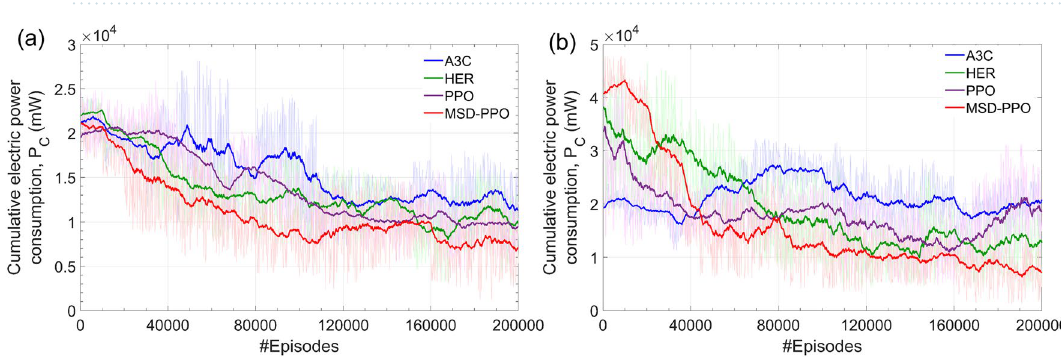
Figure 10. The smoothed cumulative transmission losses of MSD and several reinforcement learning algorithms, including A3C, HER, PPO, when the number of learning episodes increases from 0 to 200K: (a) results for environments without error nodes, and (b) results for environments with error nodes.